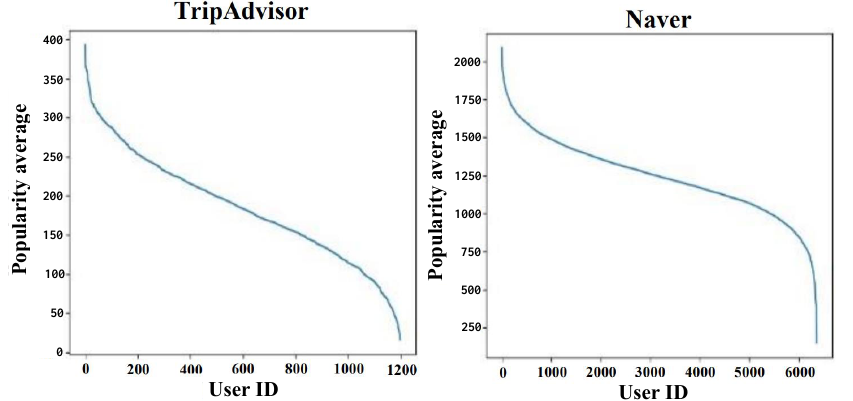
Figure 2. Average of popularity values for each